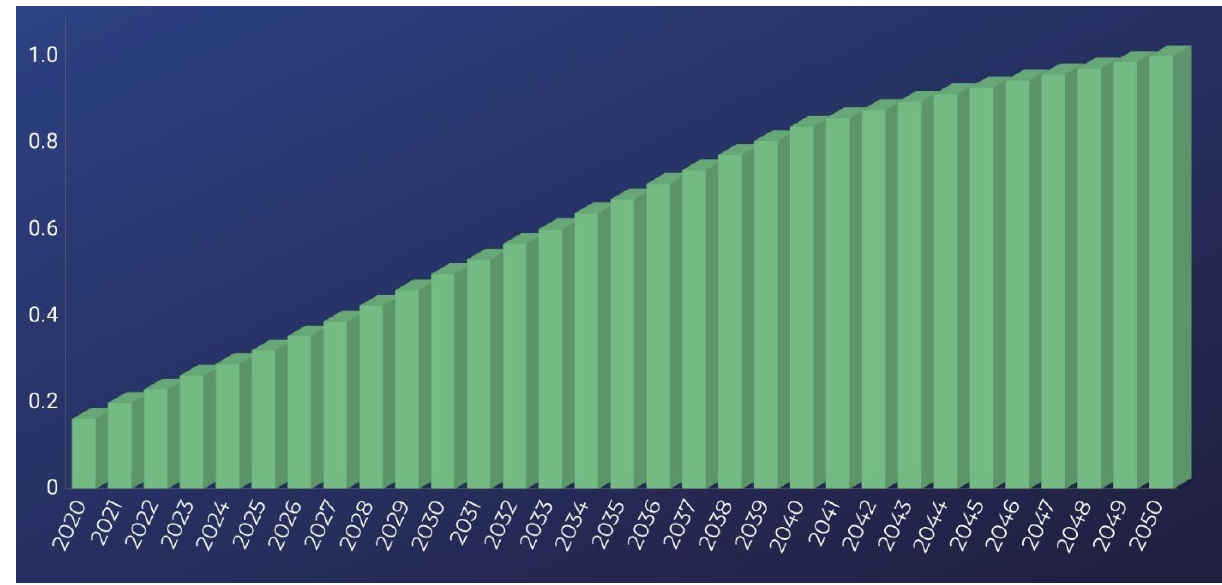
Figure 6. Pure technical efficiency (PTE) of green hydrogen production in the UAE.